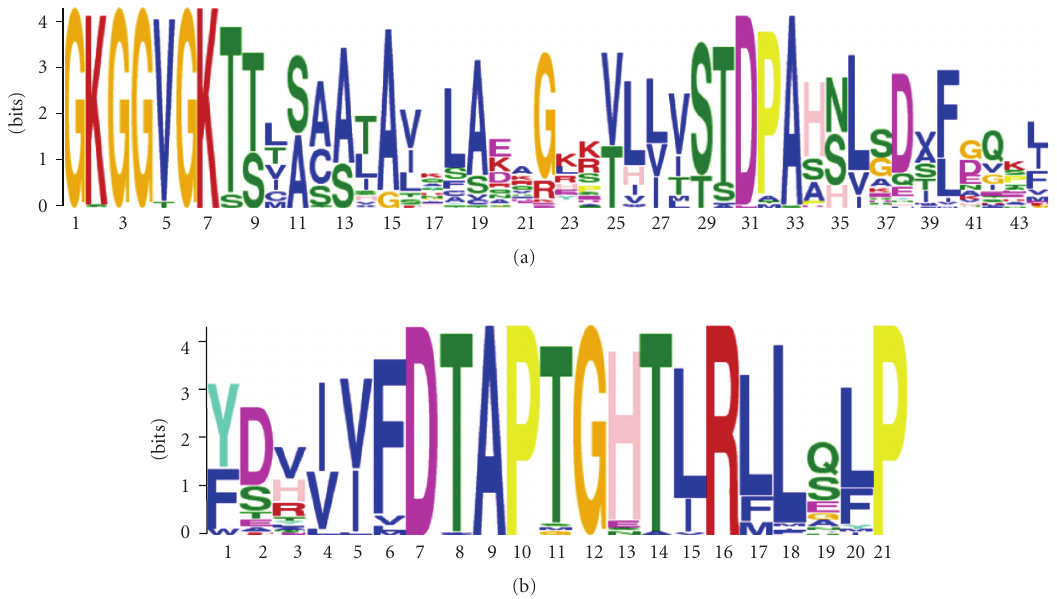
Figure 6: MEME [30] sequence logos illustrating the conserved residues of (a) motif 1 and (b) motif 2 found in ArsA homologues. The size of the letters indicates amino acid conservation, with larger letters representing more conserved